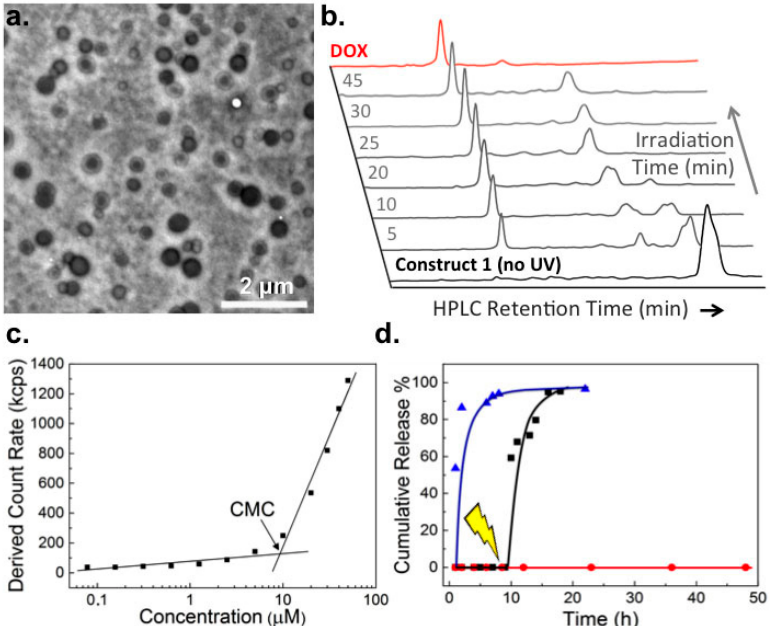
Figure 2. Characterization of doxorubicin pro-drug micelles and light induced drug release. ( a ) TEM (transmission electron microscopy) image (uranyl acetate stain) of micelles of 1 (300 µM, approx. 0.7 mg/mL); ( b ) Time evolution of the HPLC (high-performance liquid chromatography) spectra of a solution of 1 (100 µM in PBS (phosphate buffered saline)) during photolysis (365 nm, 3–5 mW/cm 2 ). Free DOX (100 µM), dissolved in PBS, was used to confirm clean photolysis of 1 to release “active” DOX. HPLC conditions described in Materials and Methods; ( c ) CMC (critical micelle concentration) determination by light scattering following serial dilution of 1 (100 µM–75 nM) in PBS; ( d ) In vitro DOX release profiles from 1 (300 µM) in PBS. No UV irradiation ( red ), UV irradiation at 9 h ( black ) and free DOX control ( blue ).